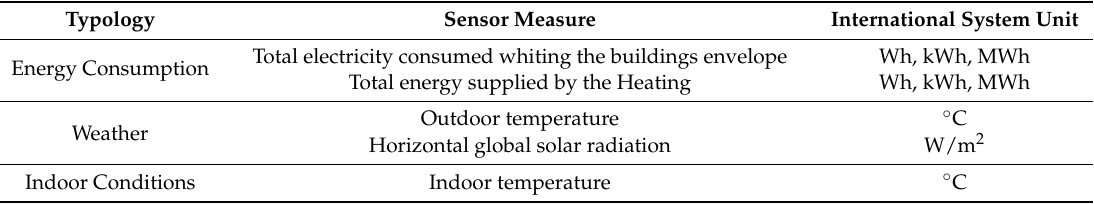
Table 4. Physical variables measured in the Corrected Average